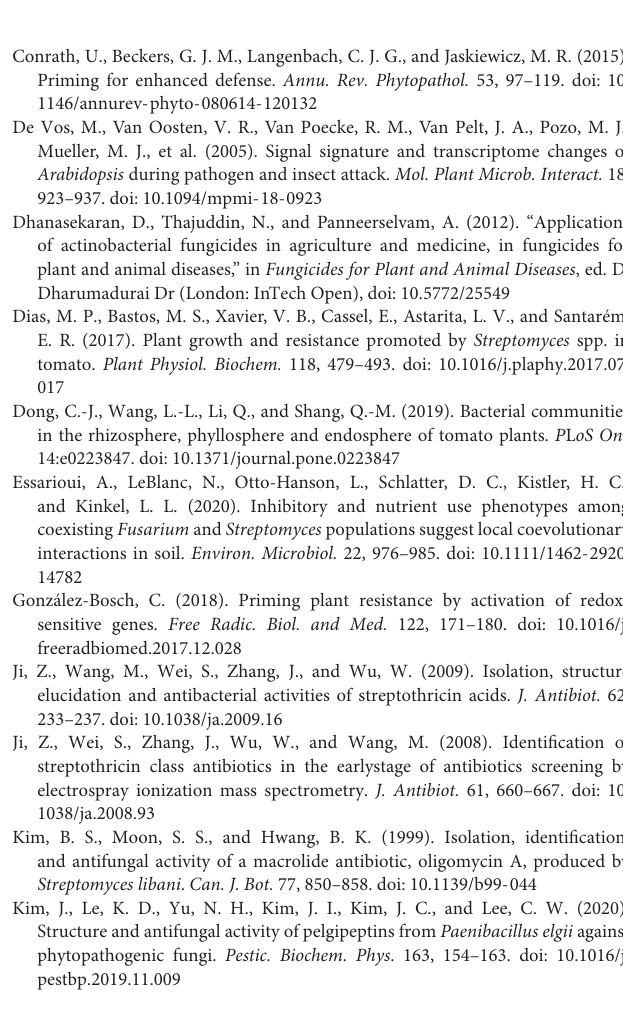
Supplementary Figure 1 | ESI-MS/MS fragmentation pattern of streptothricin E acid. Supplementary Figure 2 | ESI-MS/MS fragmentation pattern of streptothricin D. Supplementary Figure 3 | ESI-MS/MS fragmentation pattern of 12-carbamoylstreptothricin D. Supplementary Table 1 | Primer sequences used in RT-qPCR